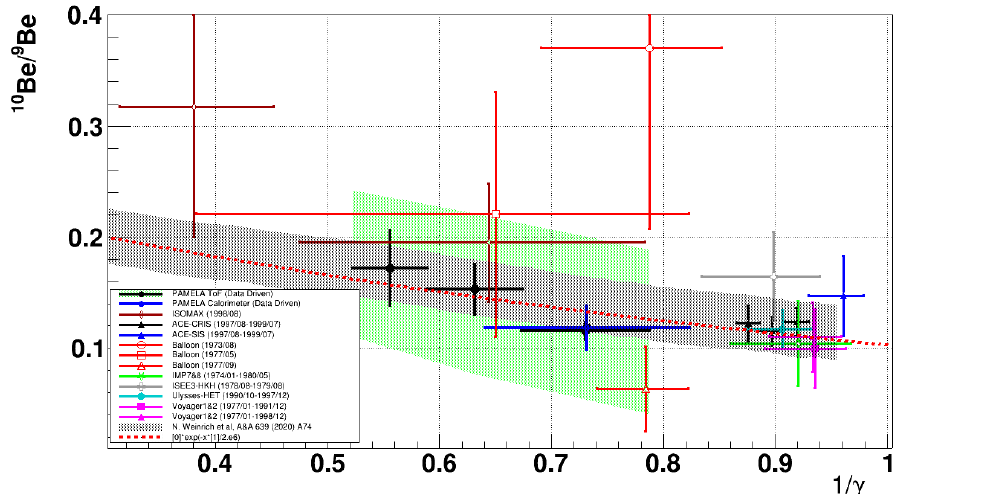
Figure 9. Measurements of the 10 Be/ 9 Be flux ratio as a function of 1/ γ . The dashed line is a phenomenological exponential fit. The new measurements obtained by the Pamela experiment using this data-driven approach strengthen the experimental indications of the expected 1/ γ